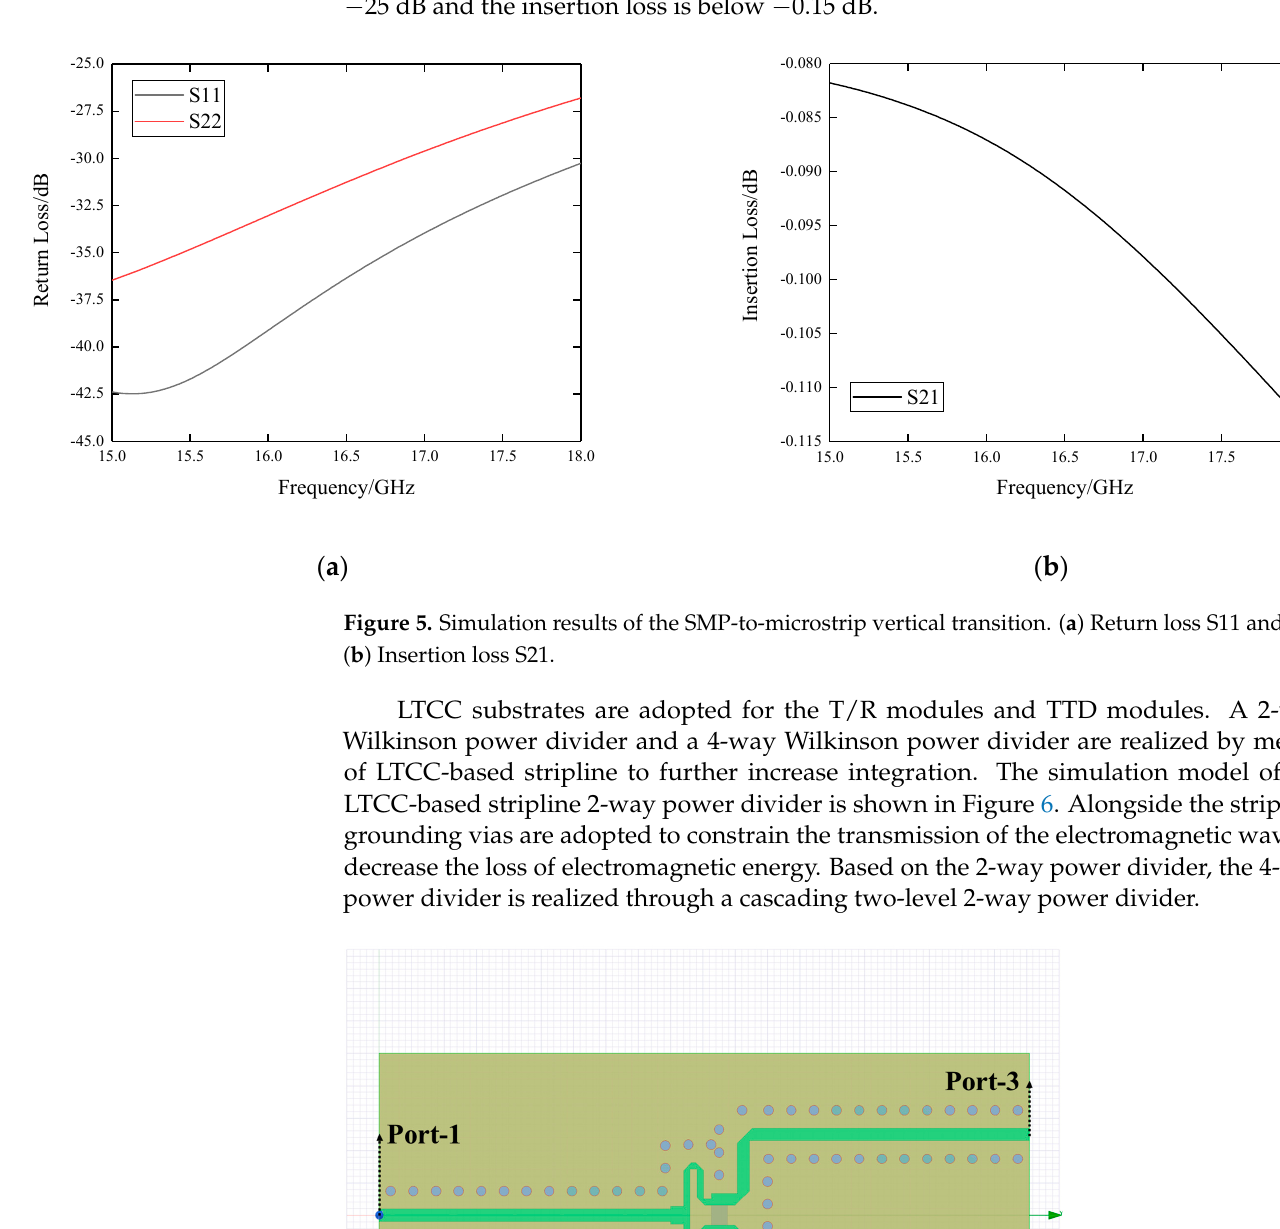
Figure 4. SMP-to-microstrip vertical transition model: ( a ) front side of the simulation model; ( b ) back side of the simulation model.